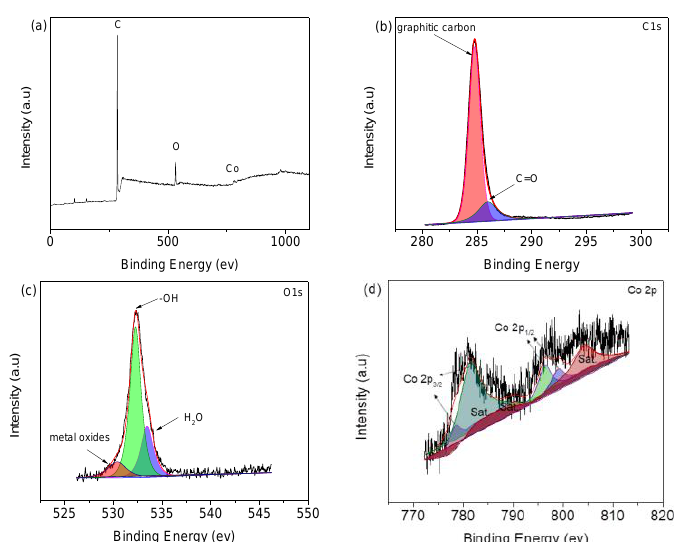
Figure 4. ( a ) XPS survey spectrum of Co 3 O 4 -infilled microcapsules. XPS spectra of ( b ) C 1s, ( c ) O 1s, and ( d ) Co 2p.